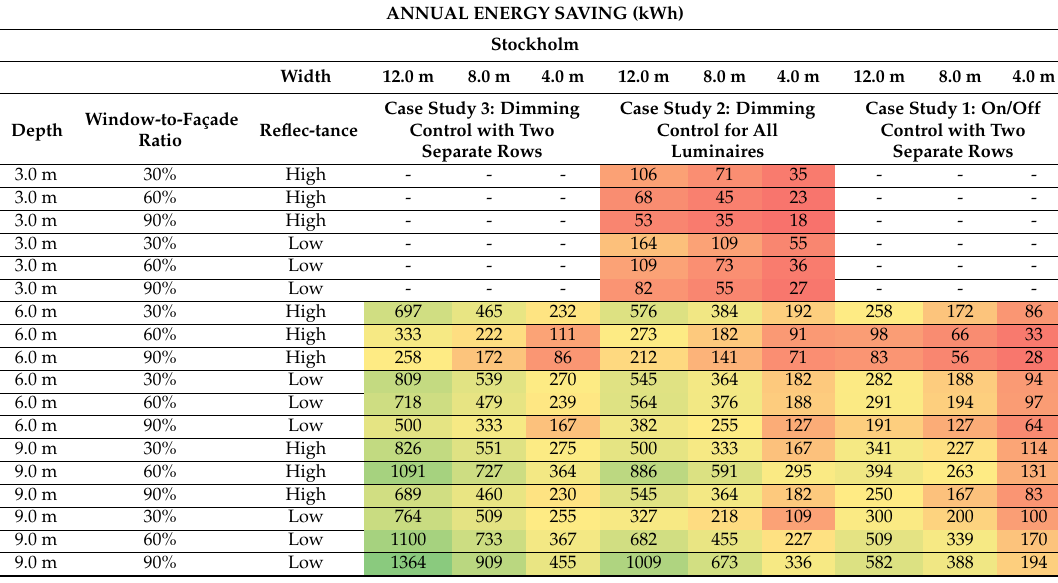
Table 7. Annual energy saving in kWh of different lighting smart controls in